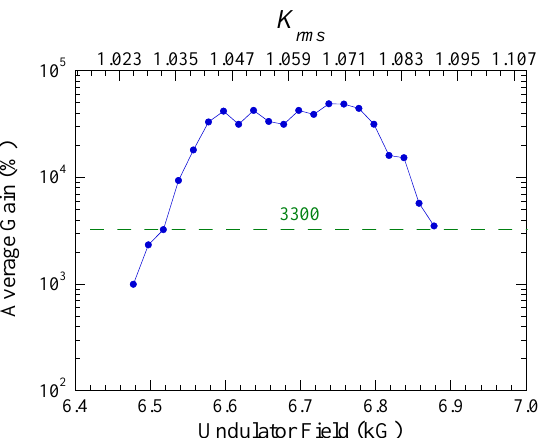
Figure 11. Average gain produced by the IR RAFEL over the first 10 passes versus the undulator field B u for a cavity length of L cav = 8.62538144 m ( ∆ L cav = − 8 λ . Other parameters as in Table